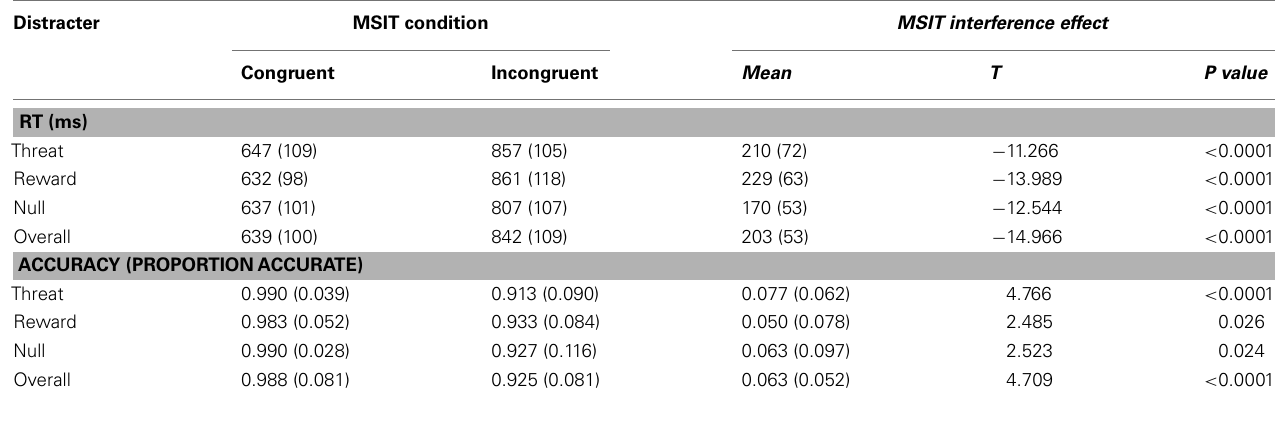
Table 1 | Summary of behavioral task